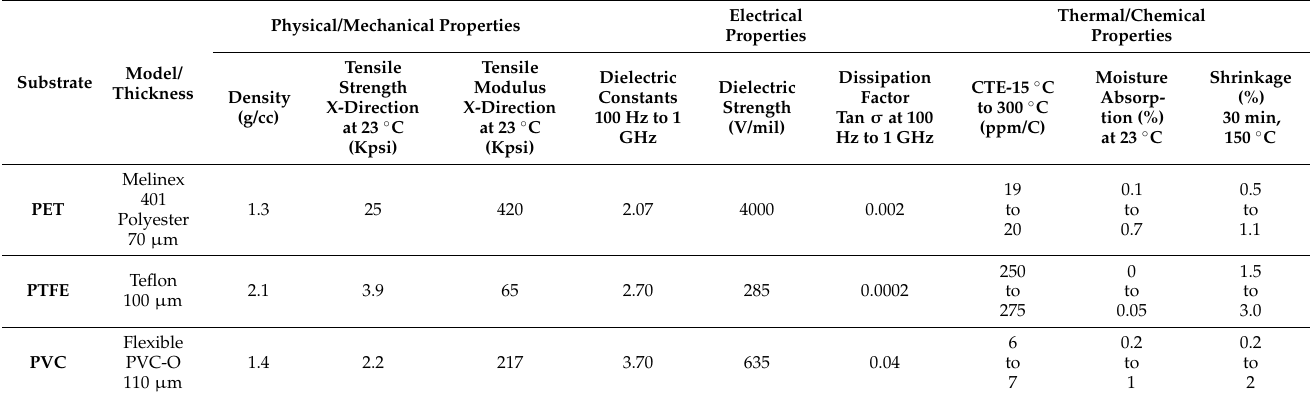
Table 2. Properties of flexible polymers: PET, PTFE,